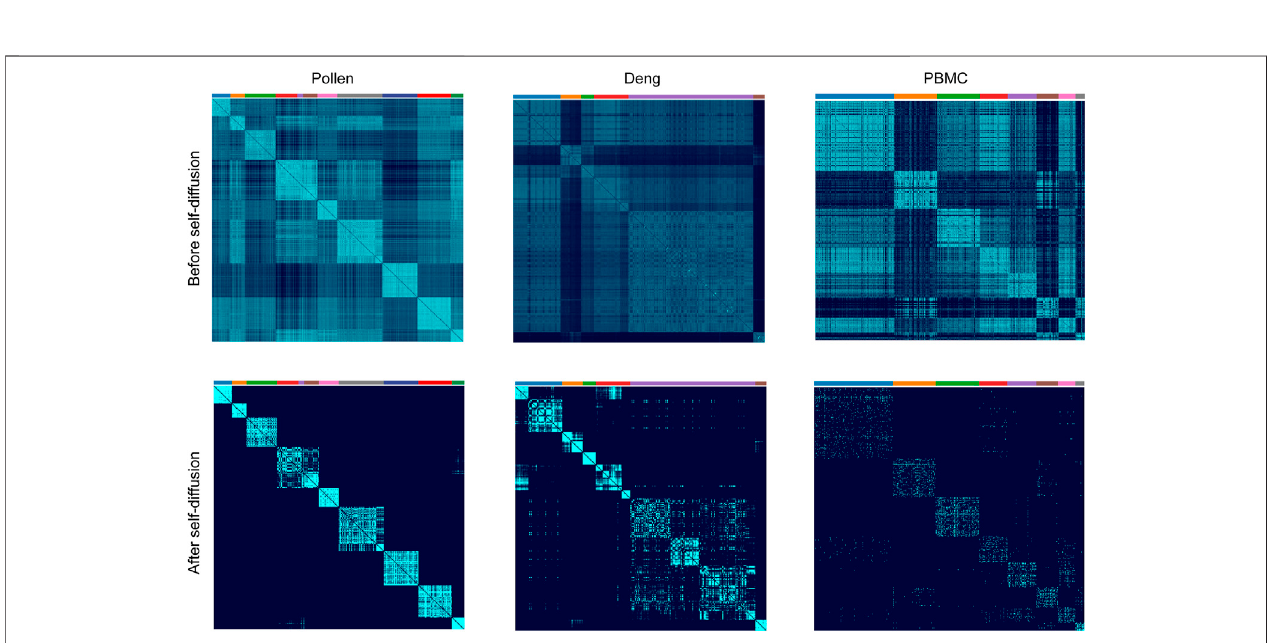
FIGURE 4 | Cell similarities ’ comparison of before and after self-diffusion on Pollen, Deng, and PBMC datasets. Visual inspection of the cell ’ s similarities after self- diffusion using LSSD reveals an enhancement of intercluster connection.